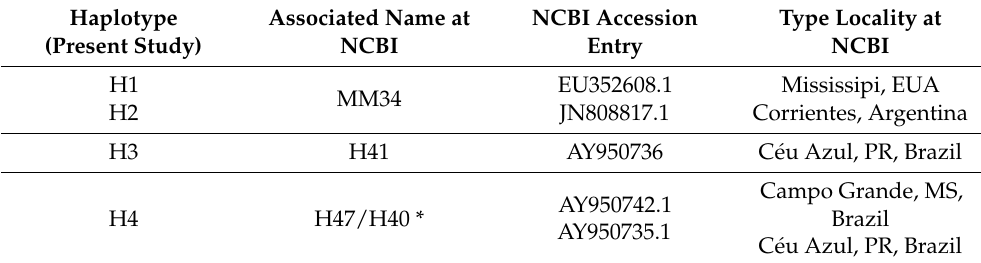
Table 1. Haplotypes of Solenopsis invicta collected from highways along the border of Atlantic Forest in S ã o Paulo, Brazil, based on 726 bp-long amplicons and sequence similarity at